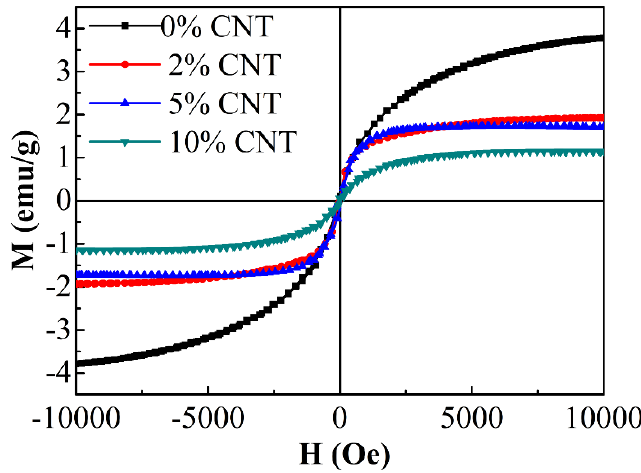
Figure 6. Field-dependent magnetizations of the composites.